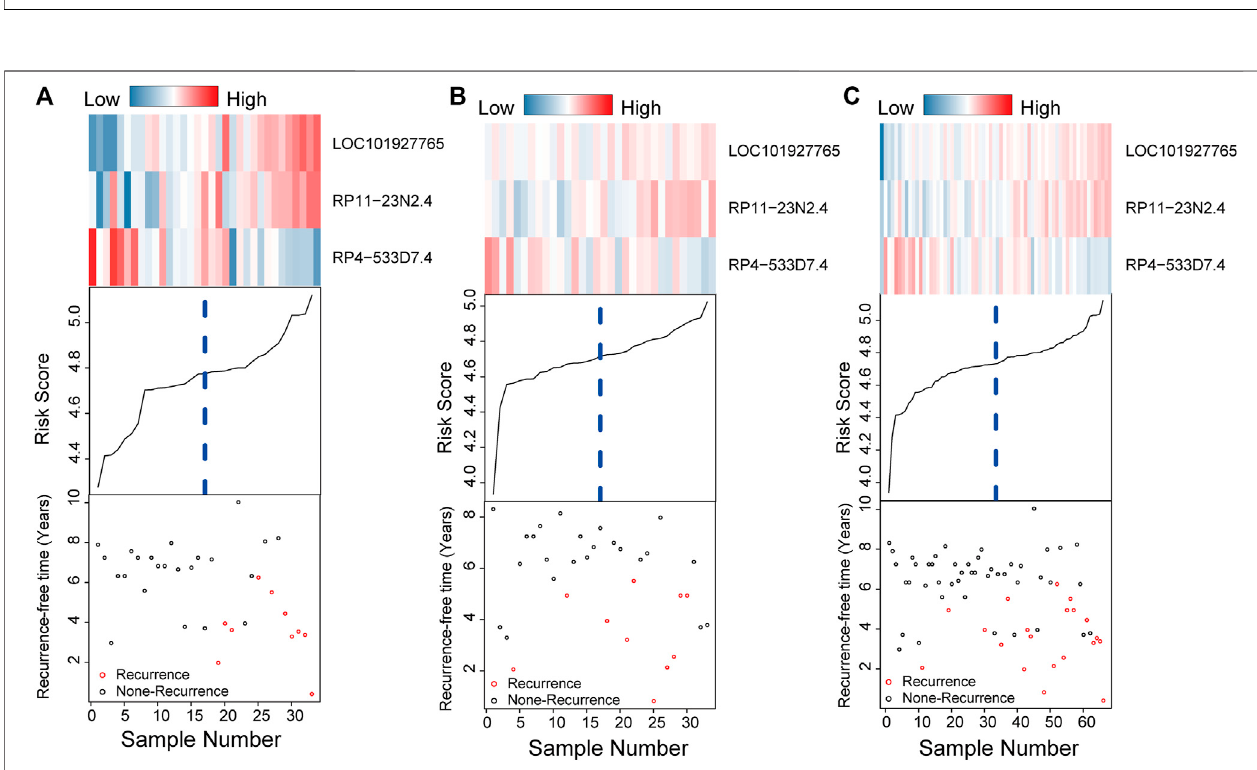
FIGURE4| Riskscoredistribution,survivalstatusandgeneexpression patternsforpatientsinhigh-andlow-riskclustergroupedbythethree-lncRNAsignaturein the training (A) , testing (B) , and independent datasets (C) .